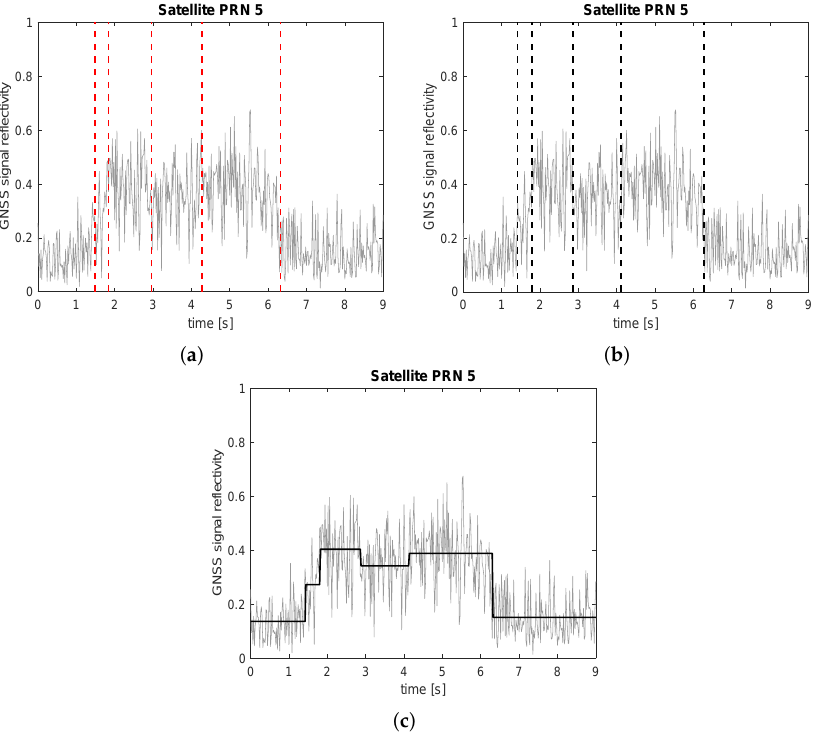
Figure 9. Segmentation of a GNSS signal obtained in an airborne experiment. ( a ) detection, ( b ) local- ization, ( c ) segmentation.